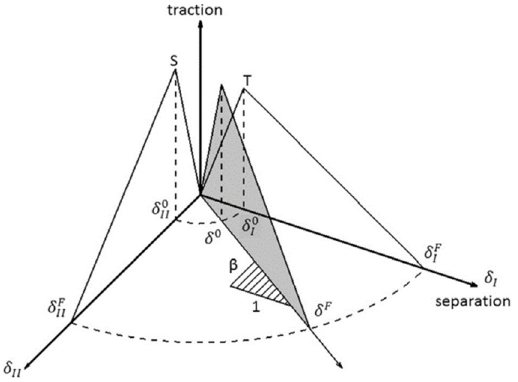
Figure 5. The bi-linear mixed-mode I + II traction-separation law [21].